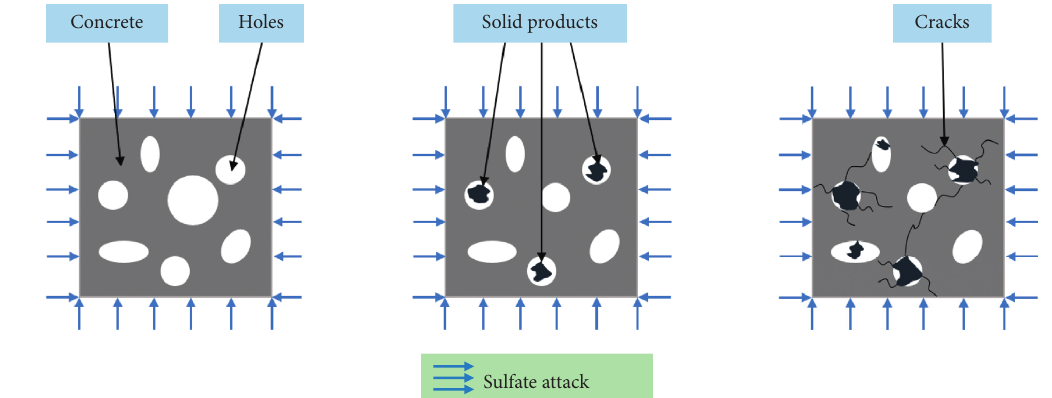
Figure 10: Process of sulfate attack on concrete. Table 8: True triaxial static compression test results of concrete after sulfate attack. Test